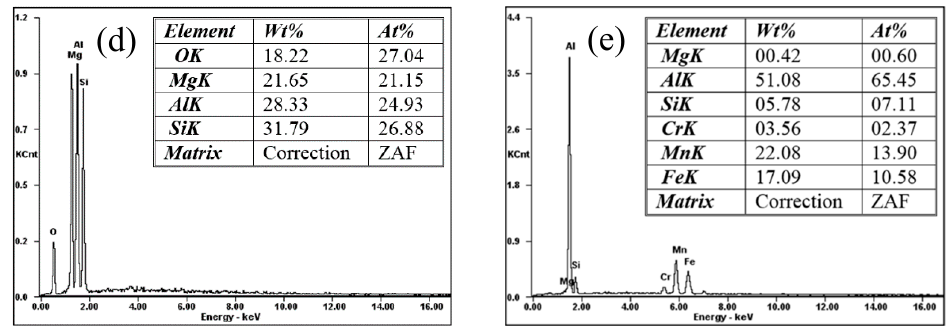
Figure 1. SEM images of the samples: ( a ) alloy A, ( b ) alloy B, and ( c ) alloy C. ( d , e ) Corresponding energy dispersive X-ray spectroscopy (EDS) results of particles from mark 1 and 2, respectively. (ZAF: Correction for Quantitative Electron-probe Microanalysis of Microparticles).